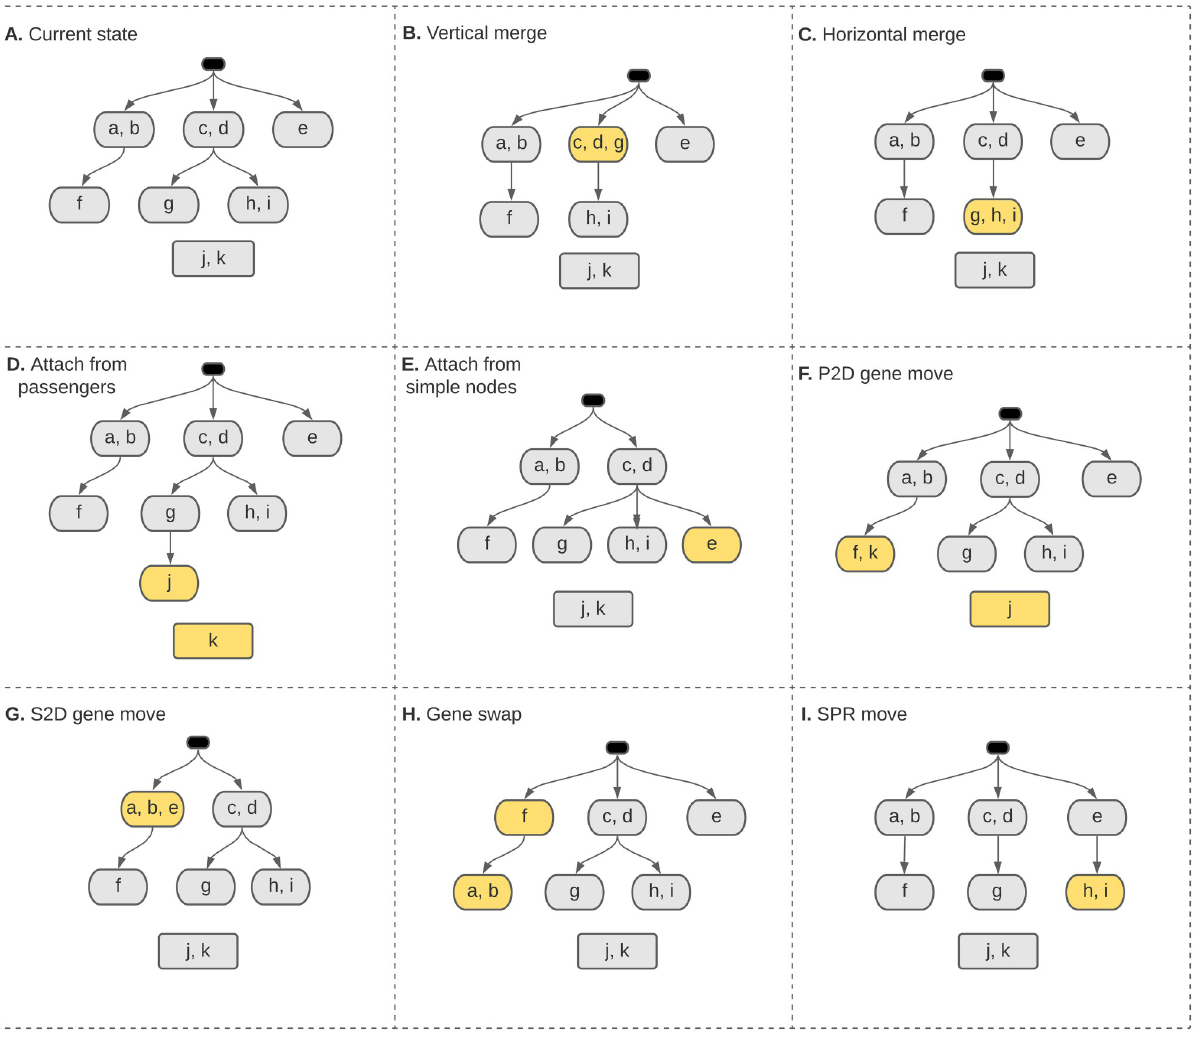
Fig 3. Different types of structural moves used in our MCMC inference